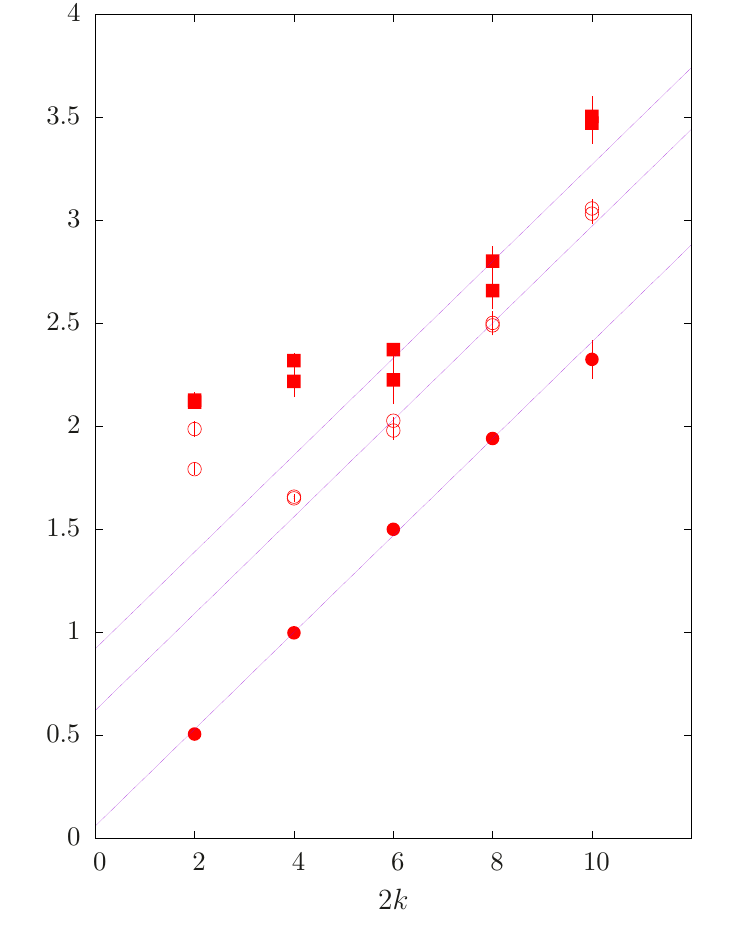
Figure 3 . Lightest Pfa(cid:14)an masses in units of the lightest trace J P = 0 + mass in our various SO(2 k ) gauge theories: J = 0 ( ), J P = 2 (cid:6) ( ) and J P = 1 (cid:6) ( (cid:4) ). (cid:15) (cid:14) a (cid:13)ux loop (cid:8) l that winds once around the periodic x direction will satisfy and Tr (cid:8) y c Tr (cid:8) l = 0 where (cid:8) c is any contractible loop. The (cid:12)nite volume states h f g f gi